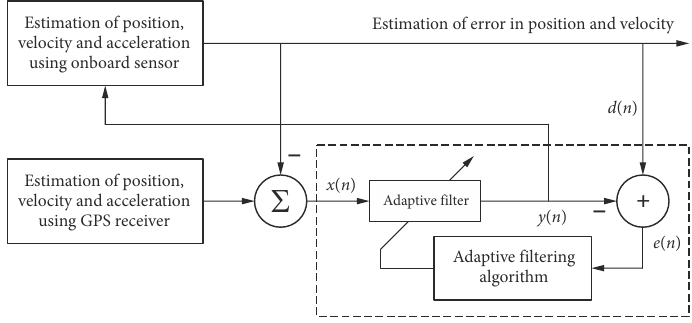
Figure 3. Multisensor datafusion scheme for train localization: n – iteration number; x ( n ) – the adaptive-filter input; y ( n ) – adaptive-filter output; d ( n ) – the desired position and velocity; e ( n ) –